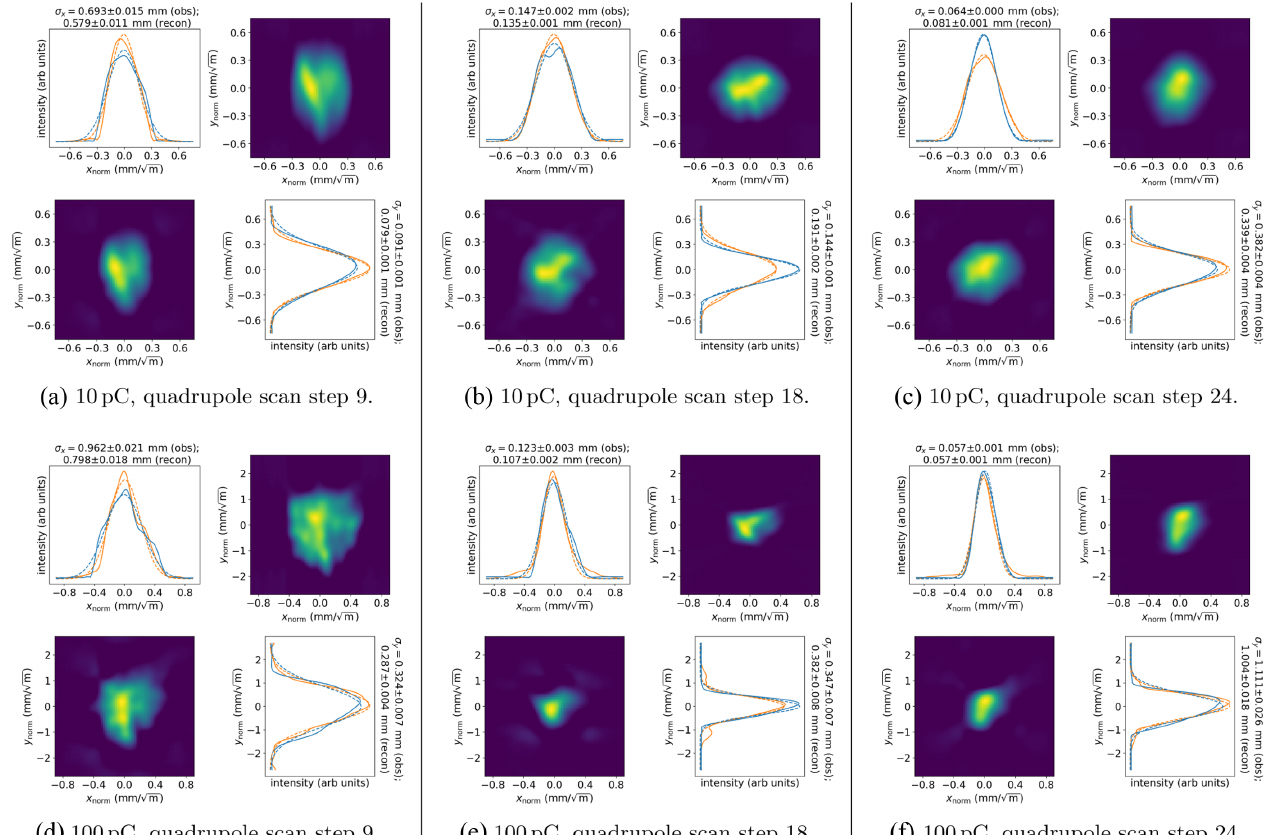
FIG. 13. Validation images for 10-pC bunch charge, found from machine learning, from three steps in the quadrupole scan. Within each set of four plots, the top right and bottom left images show (respectively) the observed and reconstructed beam image at the observation point; continuous lines in the top left and bottom right plots show the density projected onto (respectively) the horizontal and vertical axes, broken lines show Gaussian fits (used to determine the beam sizes, with values shown alongside the relevant plots). Blue lines correspond to the observed image, and orange lines correspond to the reconstructed